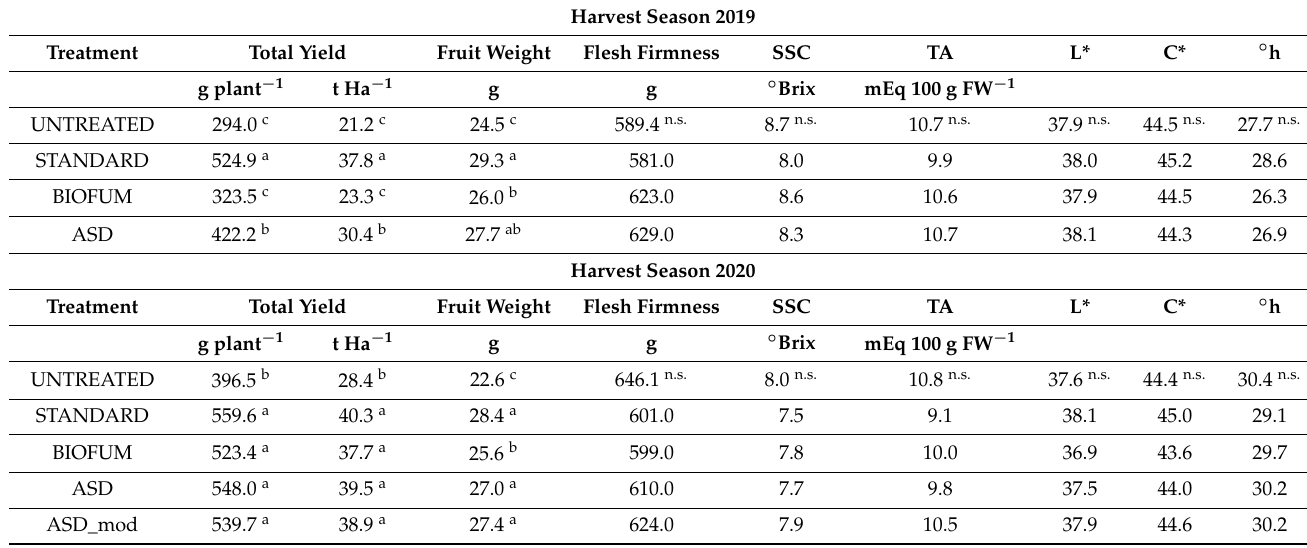
Within the same column and year, different superscript letters indicate significant differences among treatments ( p ≤ 0.05, Tukey HSD test); ‘n.s.’ indicates no significant difference. Data of harvest season 2019 are from